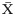
Performance at elevated temperatures.
(a) The temperature-time curve (X¯ ± s) shows smoother ramp-up and extended holdover between 57°C and 62°C (dashed lines) at a 45°C ambient temperature compared to 22°C. (n = 3) (b) Ramp-up time decreases by 1 minute (**p = 0.006) and holdover time increases by 60% compared to room temperature (*p = 0.04). (n = 3).